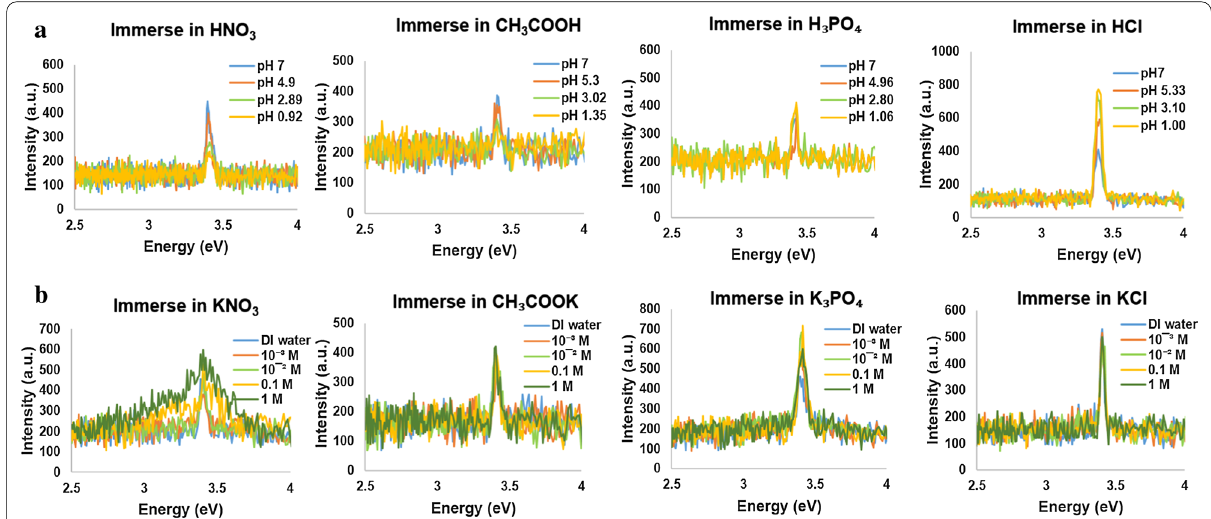
Fig. 6 PL spectra when GaN nanowires immerse in solutions of different pH or concentrations. a PL spectra of GaN nanowires in acidic solutions and b PL spectra of GaN nanowires in salt